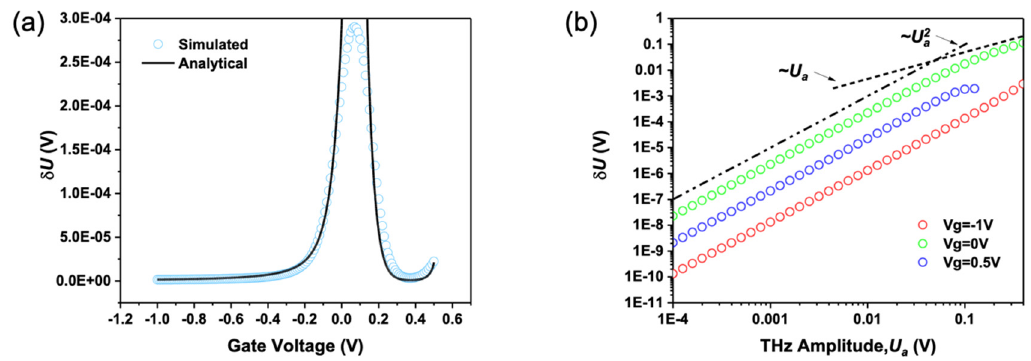
Figure 4. ( a ) Analytical (symbols) and simulated (solid line) THz responses to the 0.3 THz signal as a function of the gate voltage with a small amplitude ( (cid:1847) (cid:3028) = 0.01(cid:1848) ), ( b ) Simulated THz response versus the amplitude of radiation at (cid:1848) (cid:3034)(cid:3046) = −1, 0, and 0.5 (cid:1848) .